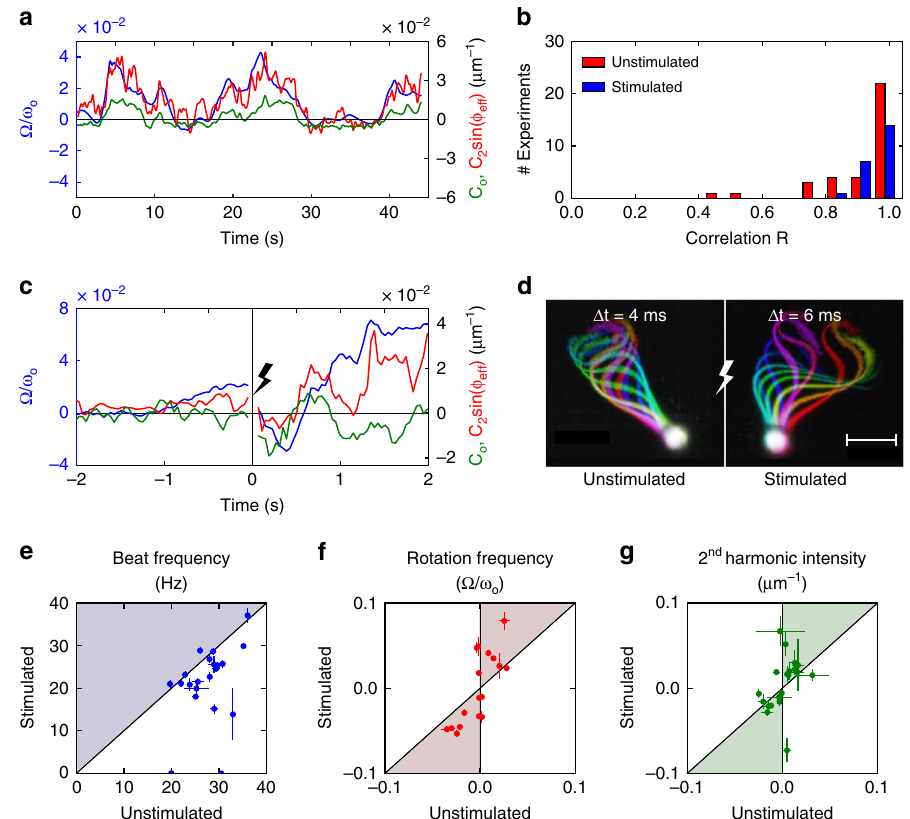
Fig. 3 Second-harmonic intensity correlates with rotation velocity and is enhanced by progesterone. a Normalized rotation velocity (blue line), second- harmonic intensity (red line), and average curvature (green line) for a representative sperm cell. b Histogram of the correlation R ( Ω / ω o , C 2 sin( ϕ eff )). Red bars refer to unstimulated human sperm, blue bars to sperm stimulated with progesterone. We never observed anti-correlation ( R < 0). c Normalized rotation velocity (blue line) and second-harmonic intensity (red line), and average curvature (green line) 2.0 s before and after the release of progesterone with a fl ash of UV light (at t = 0). d Stroboscopic views of a sperm cell before (left) and after (right) stimulation with progesterone. Flagellar snapshots were recorded at Δ t = 4 ms (left) and Δ t = 6 ms (right) intervals. Scale bar represents 10 µ m. e – g Cell by cell comparison of the beat frequency ( e ), the rotation frequency ( f ), and the second-harmonic intensity ( g ), before and after progesterone release. Average values during 0.5 s before and after the stimulus. Points inside the colored areas correspond to an increase after the stimulation. Error bars are